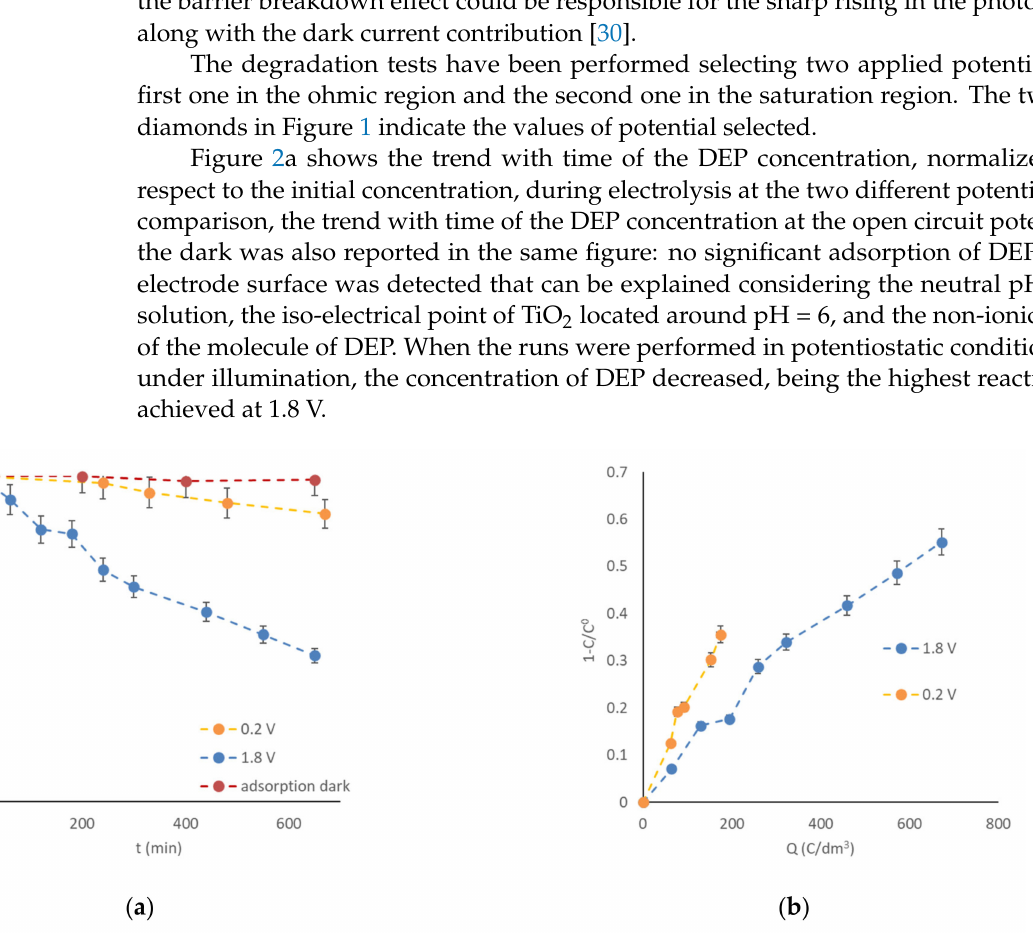
Figure 2. ( a ) Trends with time of the concentration of DEP, normalized to the initial concentration C 0 , during runs performed with solutions containing 40 mg dm − 3 DEP in 0.1 M NaClO 4 as supporting electrolyte at different applied potentials. ( b ) Fraction of reactant removed as a function of the specific charge supplied during the related